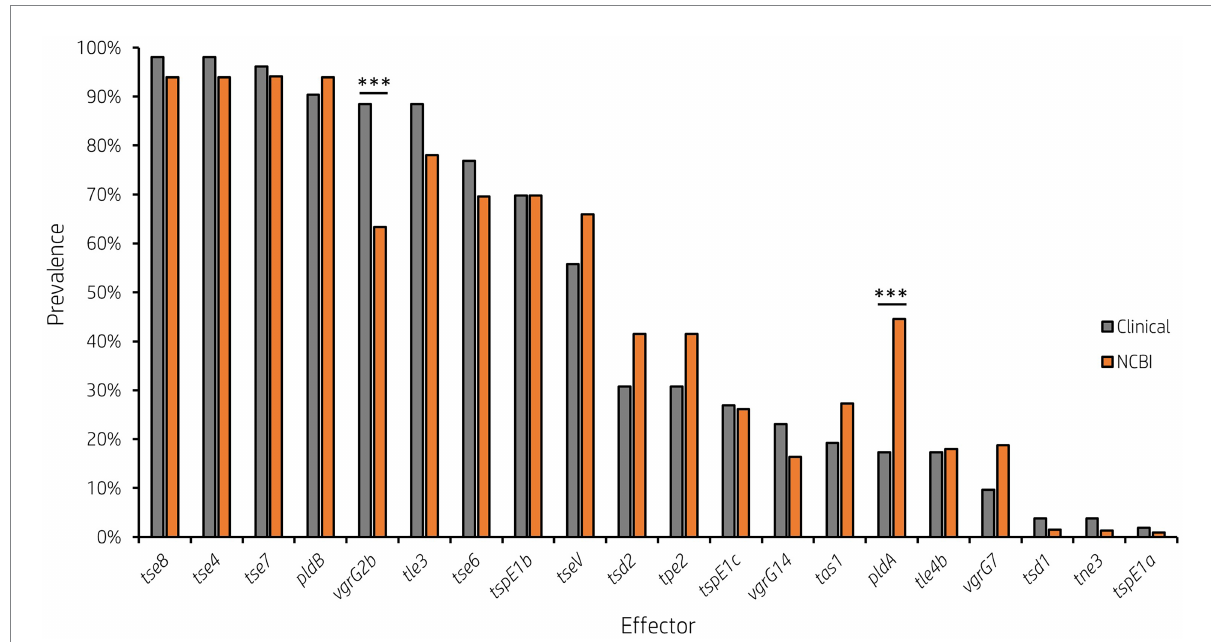
FIGURE 14 Prevalence of genes encoding T6SS effectors is variable across all publicly available P. aeruginosa isolates of assembly level ‘complete’ or higher. Grey bars represent the 52 clinical P. aeruginosa genomes under study and orange bars represent the 532 publicly available NCBI RefSeq P. aeruginosa genomes (*** p < 0.001, χ 2